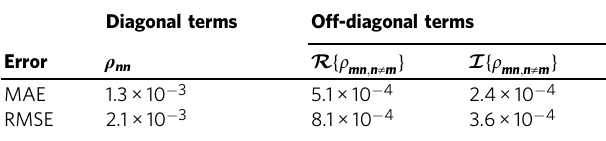
Table 1 Mean absolute error (MAE) and root mean square error (RMSE) averaged over 600 test trajectories propagated up to 1 ns.